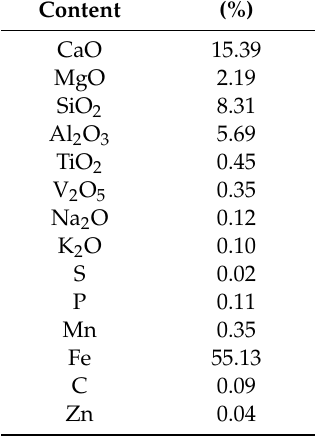
Table 2. Chemical analysis of the OXYFINES sinter used in the system modelling and analysis.